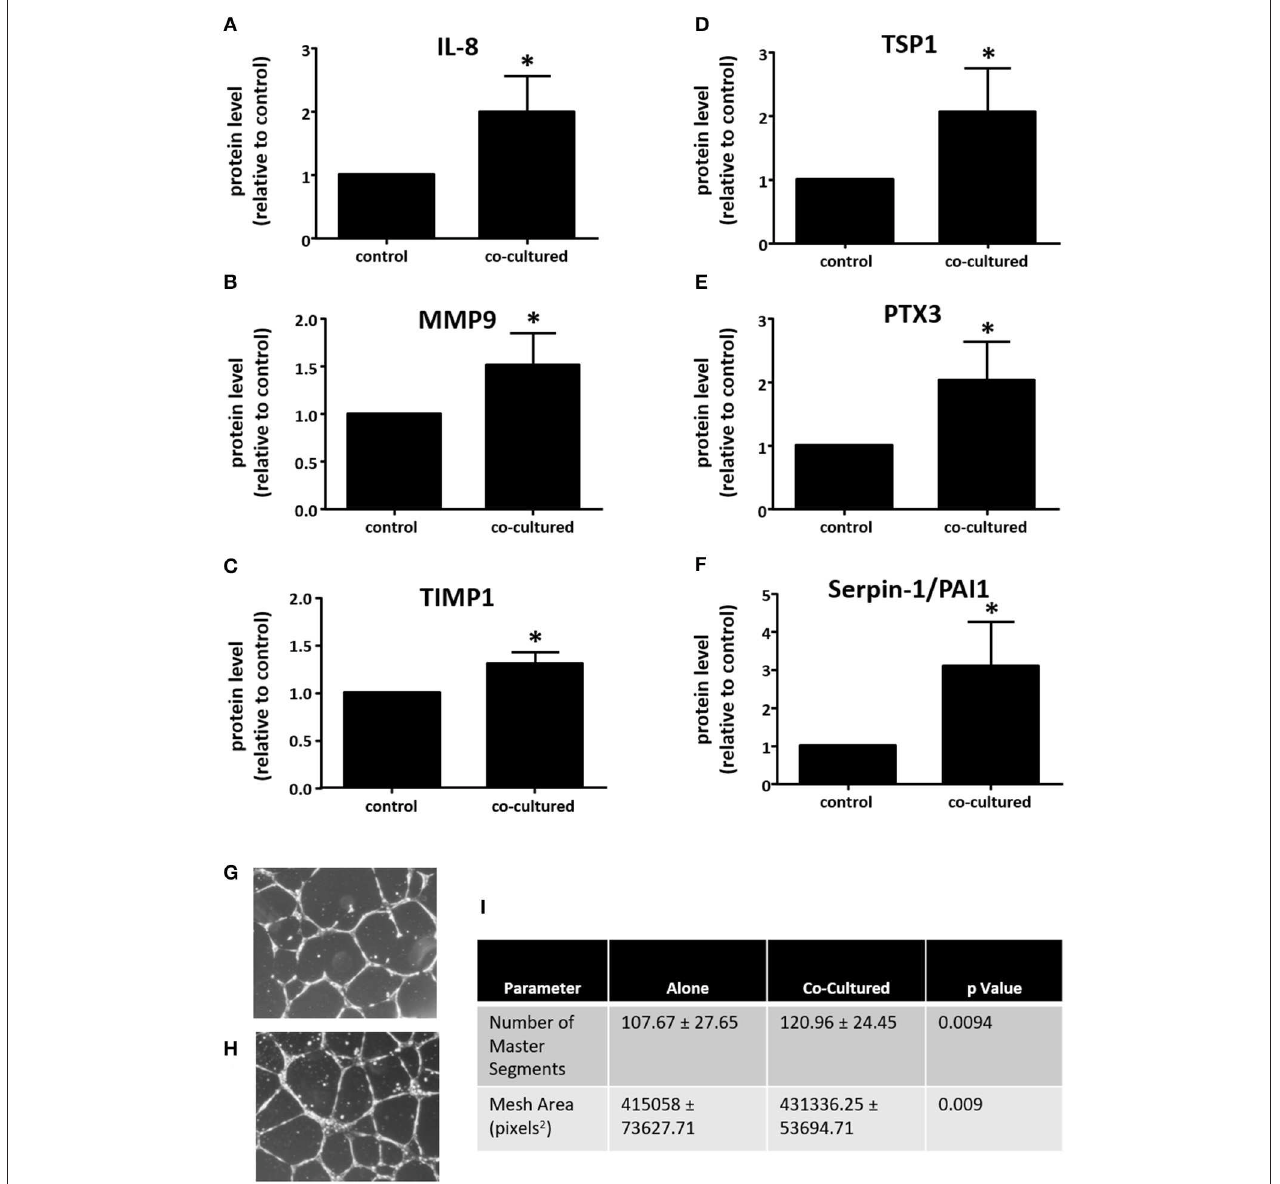
FIGURE 5 | Adipocyte-exposed macrophages produce more angiogenesis regulating proteins. THP-1 were differentiated with PMA and either cultured alone (control) or with primary human breast adipocytes for 8h, then changed to fresh media for an additional 16h before collecting conditioned media, which was assayed on Angiogenesis Array nitrocellulose membranes pre-spotted with capture antibodies for 55 angiogenesis related proteins ( n = 3, * p < 0.05); statistical analyses were performed using standard deviation and the unpaired Student’s t -test. (A) IL-8; (B) MMP9; (C) TIMP1; (D) TSP1; (E) PTX3; and, (F) Serpin-E1/PAI1 protein expression levels. Endothelial tube formation assay was performed with adipocyte-exposed macrophage supernatant (H) and control macrophage supernatant (G) . HUVEC incubated in media conditioned with macrophages not exposed to adipocytes. (I) Table of parameters measured that significantly increased in the HUVEC tube formation assay when HUVEC were incubated in media conditioned with macrophages cultured alone (control) or those co-cultured with adipocytes [statistical analyses were performed using standard deviation and the 2-way ANOVA with factors for experiment ( n = 4) and treatment (macrophages cultured alone vs. macrophages co-cultured with